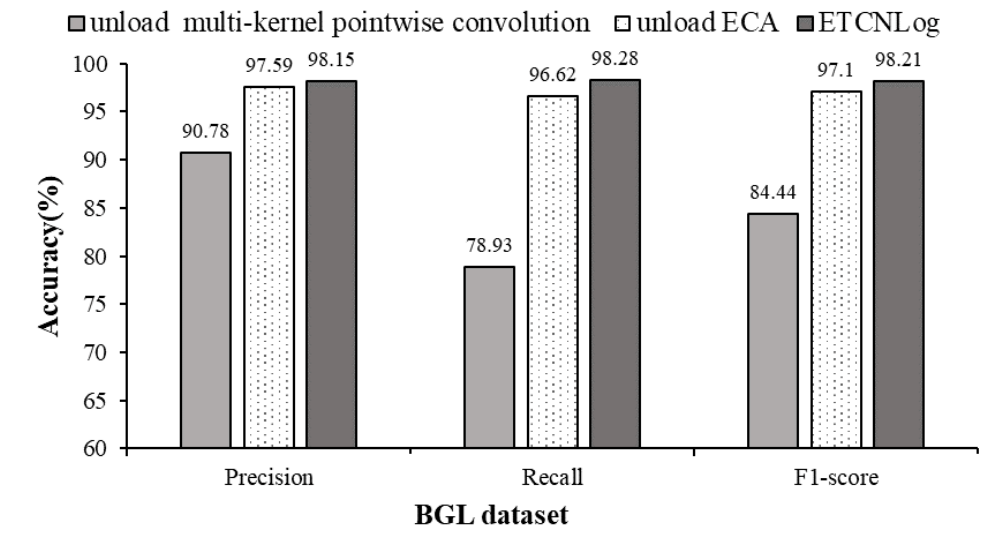
Figure 8. Comparison of model